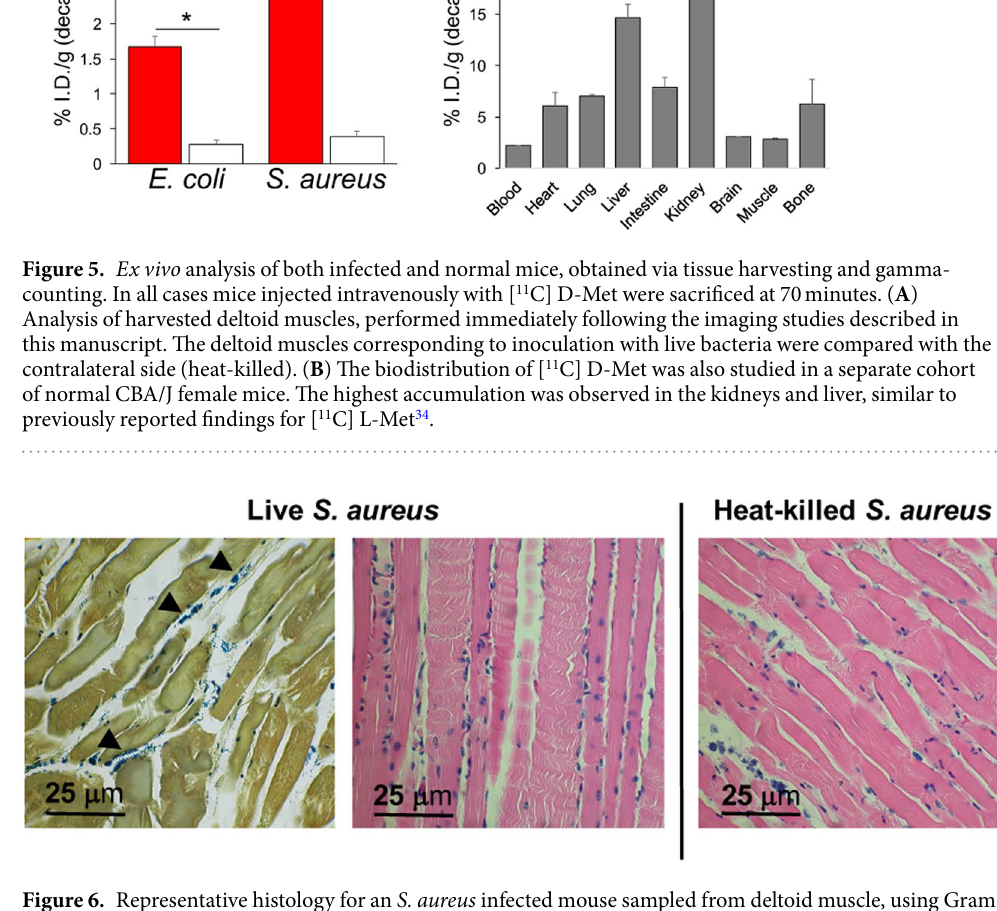
Figure 6. Representative histology for an S. aureus infected mouse sampled from deltoid muscle, using Gram- staining (left image) and hematoxylin & eosin (H&E, center and right image). In live inoculations, scattered inflammatory cells and intact bacteria are seen, best identified by Gram-staining and denoted by arrowheads. In heat-killed inoculations (right), several inflammatory cells are present on H&E staining without discernible bacteria. Images are representative of four